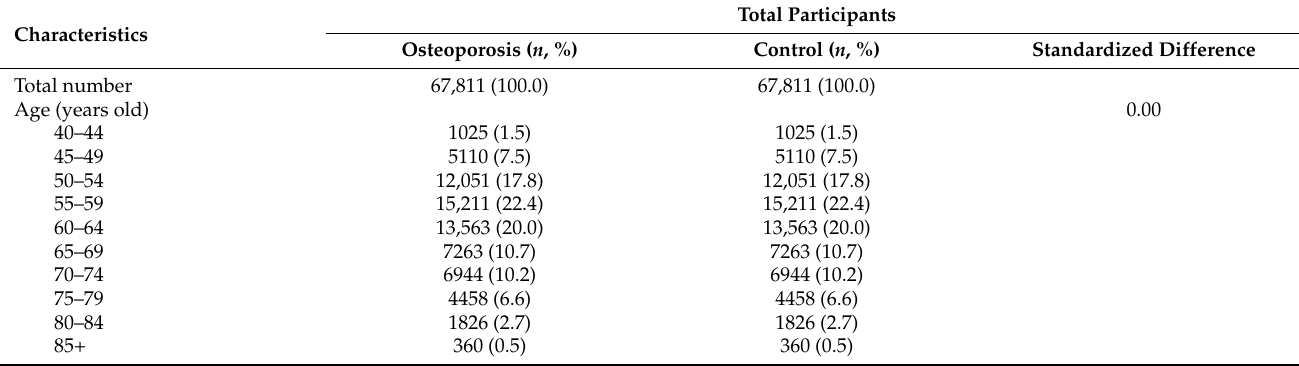
Table 1. General Characteristics of